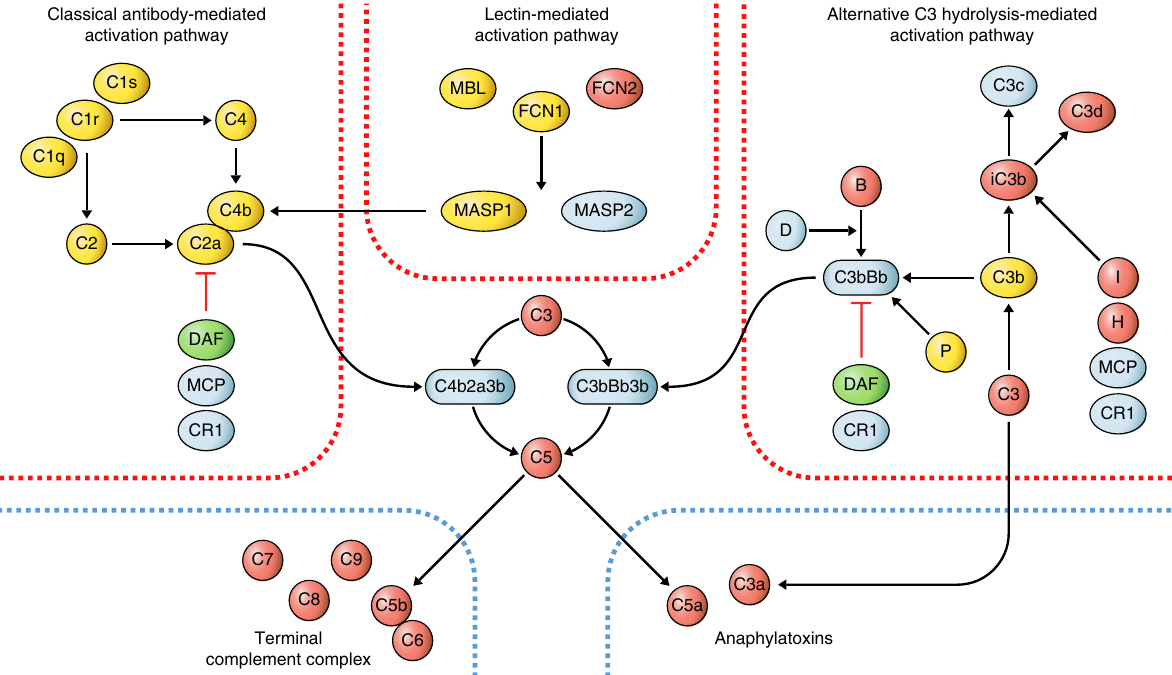
Fig. 3 Association of complement system components with development of heart failure. Diagram of protein interactions in the complement system based on a published review 59 . The three activation pathways (red borders) lead to activation of complement factor 3 which ampli fi es the signal via feedback loops, and further activates the two common effector pathways: the anaphylatoxins and the terminal complement complex (blue dashed borders). Directionality of signi fi cant associations ( p < 0.05) with incident heart failure (HF) from Cox proportional hazards regression models adjusting for age and sex ( n = 583 population-representative controls, 185 cases) is indicated for each component with color codes, where red indicates higher concentration with incident HF, green lower concentrations, and yellow no signi fi cant association. White color indicates that the component was not present on the aptamer-based proteomics